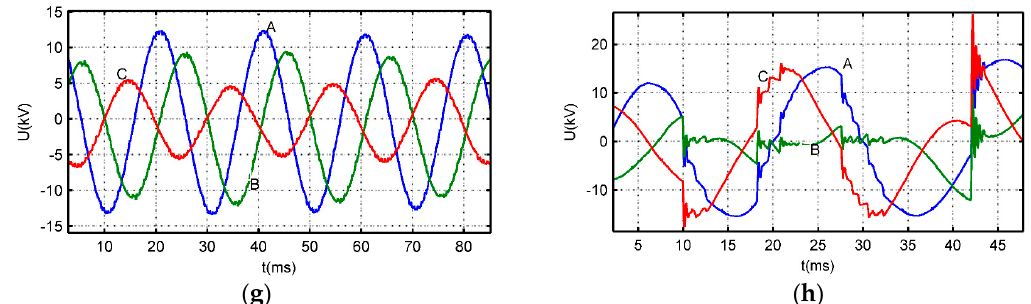
Figure 5. Typical field-captured overvoltage waveforms. ( a ) Induced lightning; ( b ) Detail view of induced lightning; ( c ) Switching capacitors; ( d ) Switching-off idle transformer; ( e ) Asymmetric short circuit; ( f ) High-frequency ferromagnetic resonance; ( g ) Fundamental ferromagnetic resonance; ( h ) Arc grounding.